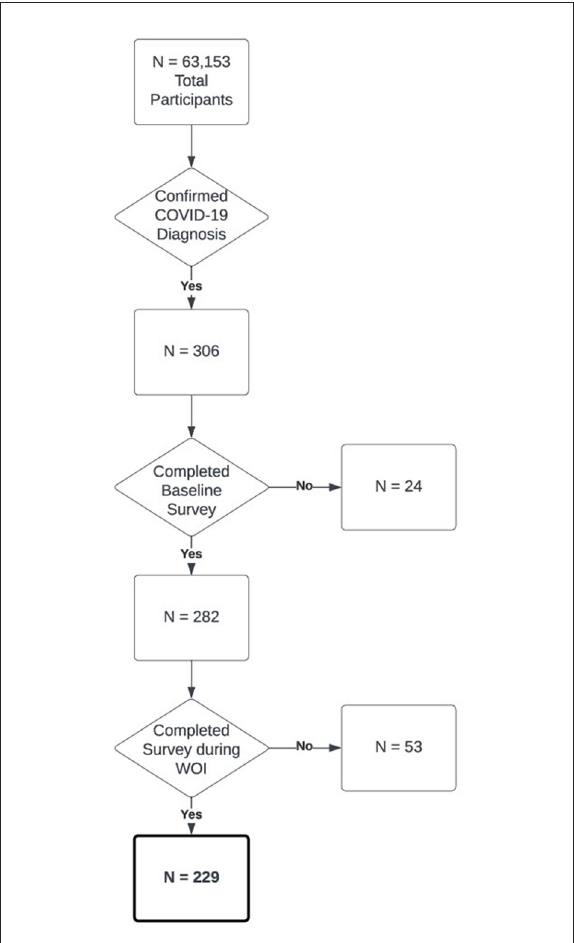
FIGURE1 Flowchart of cohort selection for the COVID-19 positive cohort in this paper out of all participants in the